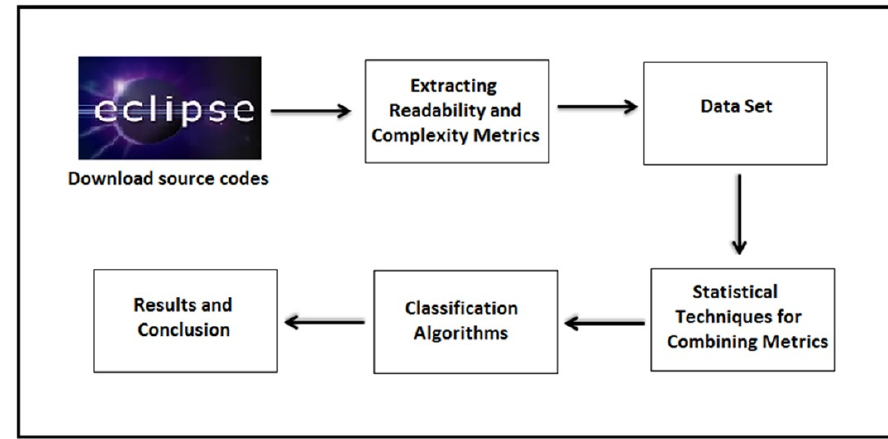
Figure 1. Research methodology